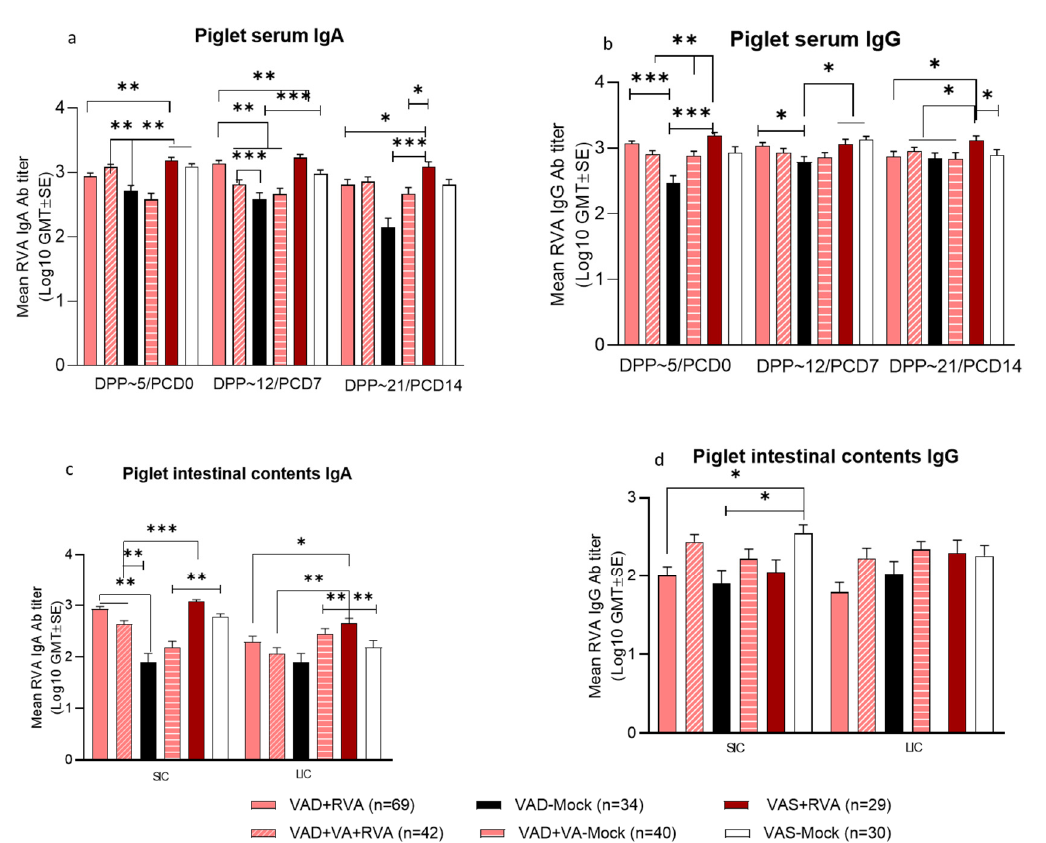
Figure 6. Mean RVA specific IgA antibody titers ( a , c ) and IgG antibody titers ( b , d ) in serum ( upper ) and intestinal contents ( lower ) of piglets of RVA(OSU)/mock inoculated sows fed VAS and VAD (±VA) diets during gestation and lactation (* p < 0.05; ** p < 0.01; *** p < 0.001), SIC—small intestinal contents, LIC—large intestinal contents.